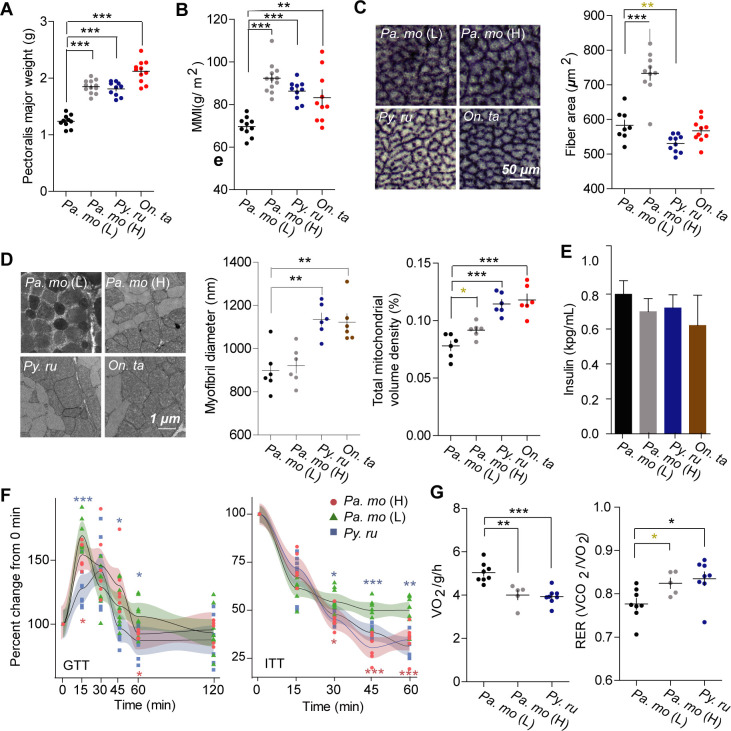
Increase in muscle mass and insulin sensitivity in high-altitude songbirds.(A) High-altitude birds increase pectoralis major weight [n = 10 for Pa. mo (H) and snow finches, and 12 for Pa. mo (L)]. (B) Muscle mass vs. body length ratio (MMI) was also greater in highland birds. Succinate dehydrogenase (SDH) staining (C) and transmission electron microscopy (TEM) (D) images of pectoralis muscle show variable fiber size or myofibril size, and a significantly greater mitochondrial volume densities in highland songbirds [n = 8 for Pa. mo (L), and 10 for highland birds for SDH; n = 6 each for TEM]. (E) Fasting plasma insulin was similar across altitudinal birds (n = 7 each). (F) Glucose and insulin tolerance test confirmed the improvement in insulin sensitivity in high-altitude birds [n = 6 each for insulin measurement; n = 8 for Pa. mo (L) and Py. ru, and 6 for Pa. mo (H) for GTT and ITT tests]. (G) Lower metabolic rates and higher carbohydrate utilization were observed in highlanders [n = 8 for Pa. mo (L) and Py. ru, and 5 for Pa. mo (H)].